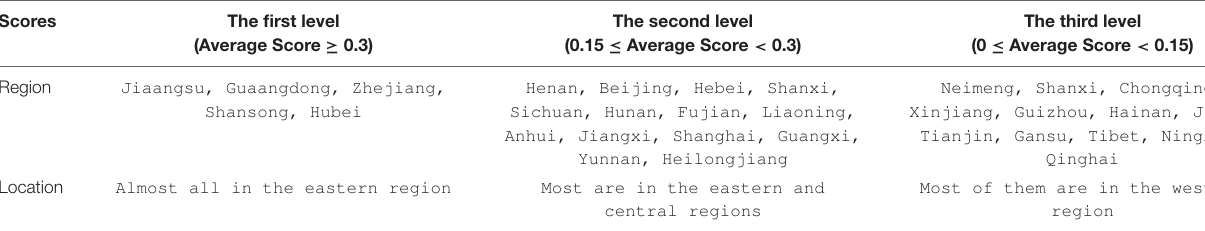
The second level (0.15 ≤ Average Score < 0.3)